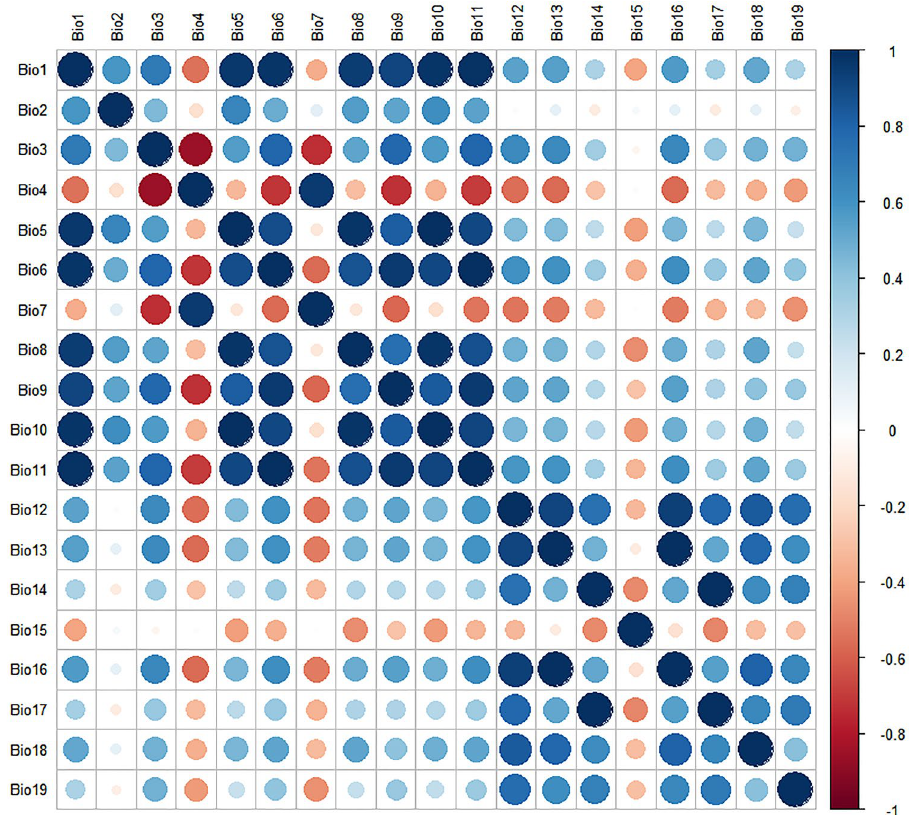
Figure 9. Correlation analysis of various environment variables. Created in R 4.1.2 (https:// www.r- proje ct.